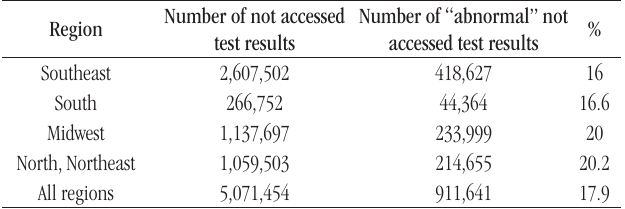
taBLE 3 – Absolute number of not accessed test results, performed by 81 laboratories in the period between May 1, 2016 and May 1, 2017, which presented “abnormal” values and their respective rates, by Brazilian geographic region Number of not accessed Region